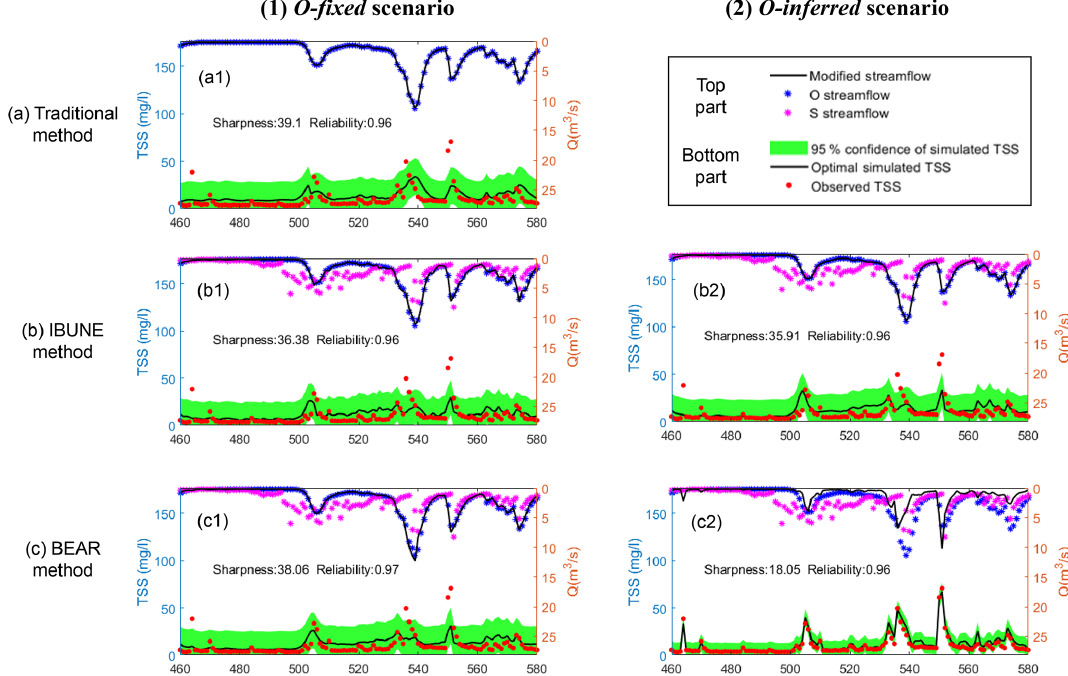
Figure B5. Comparison of the time series of synthetic data and uncertainty bands estimated via three calibration methods (including the traditional method, the IBUNE method, and the BEAR method; algorithms are explained in Sect. 2.4) for a select period of the O -fixed and O -inferred scenarios in the real case (notations are given in Table 2).